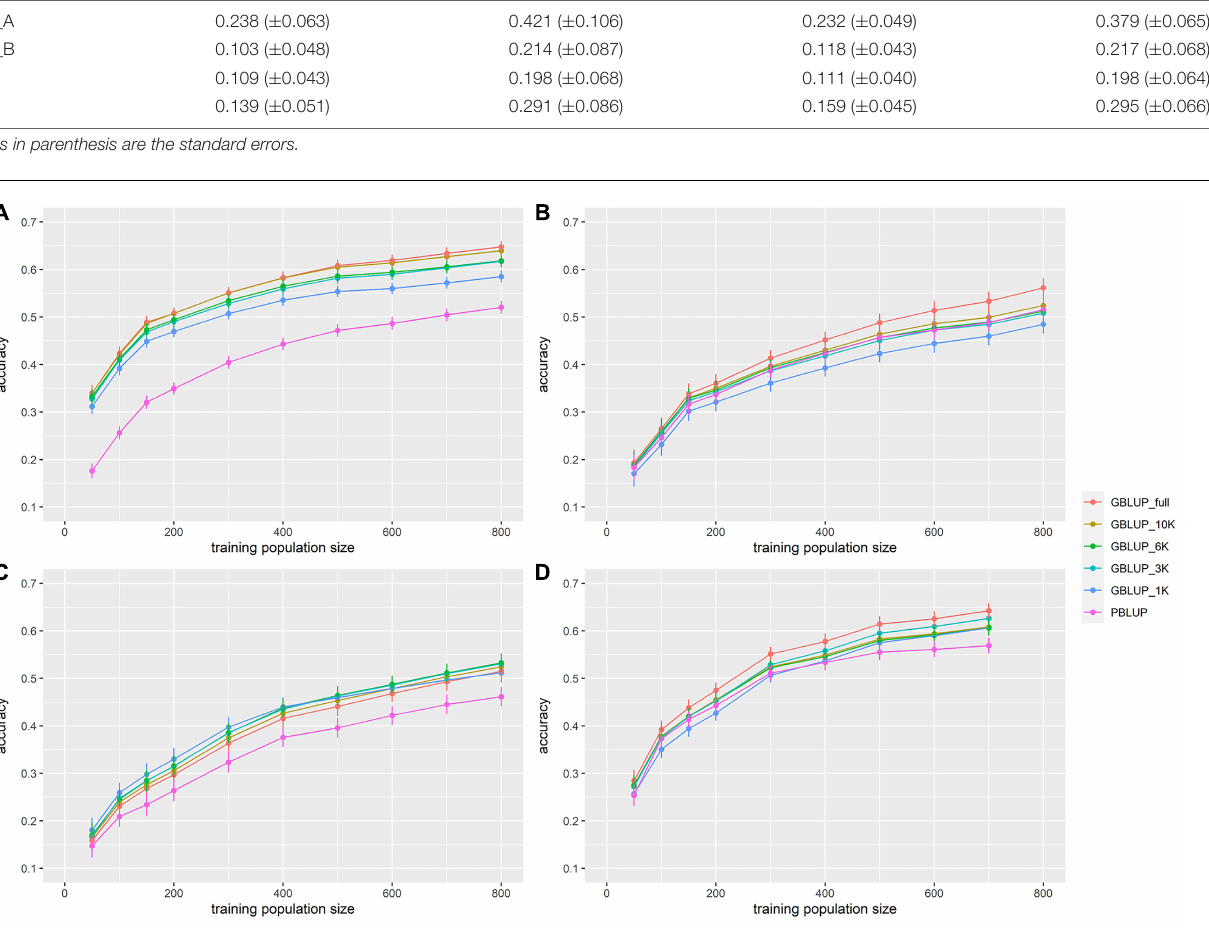
FIGURE 2 | Accuracy of genomic (GBLUP) and pedigree-based (PBLUP) estimated breeding values for disease resistance as a function of the number of individuals in the training population, and for different marker densities, in (A) European sea bass commercial cohort VNN_A challenged to NNV, (B) European sea bass commercial cohort VNN_B challenged to NNV, (C) European sea bass commercial cohort VIB challenged to V. harveyi , and (D) gilthead sea bream commercial cohort PAS challenged to Photobacterium damselae subsp. piscicida . Each point is the average of 100 replicates. Error bars represent the standard error of the mean of 100